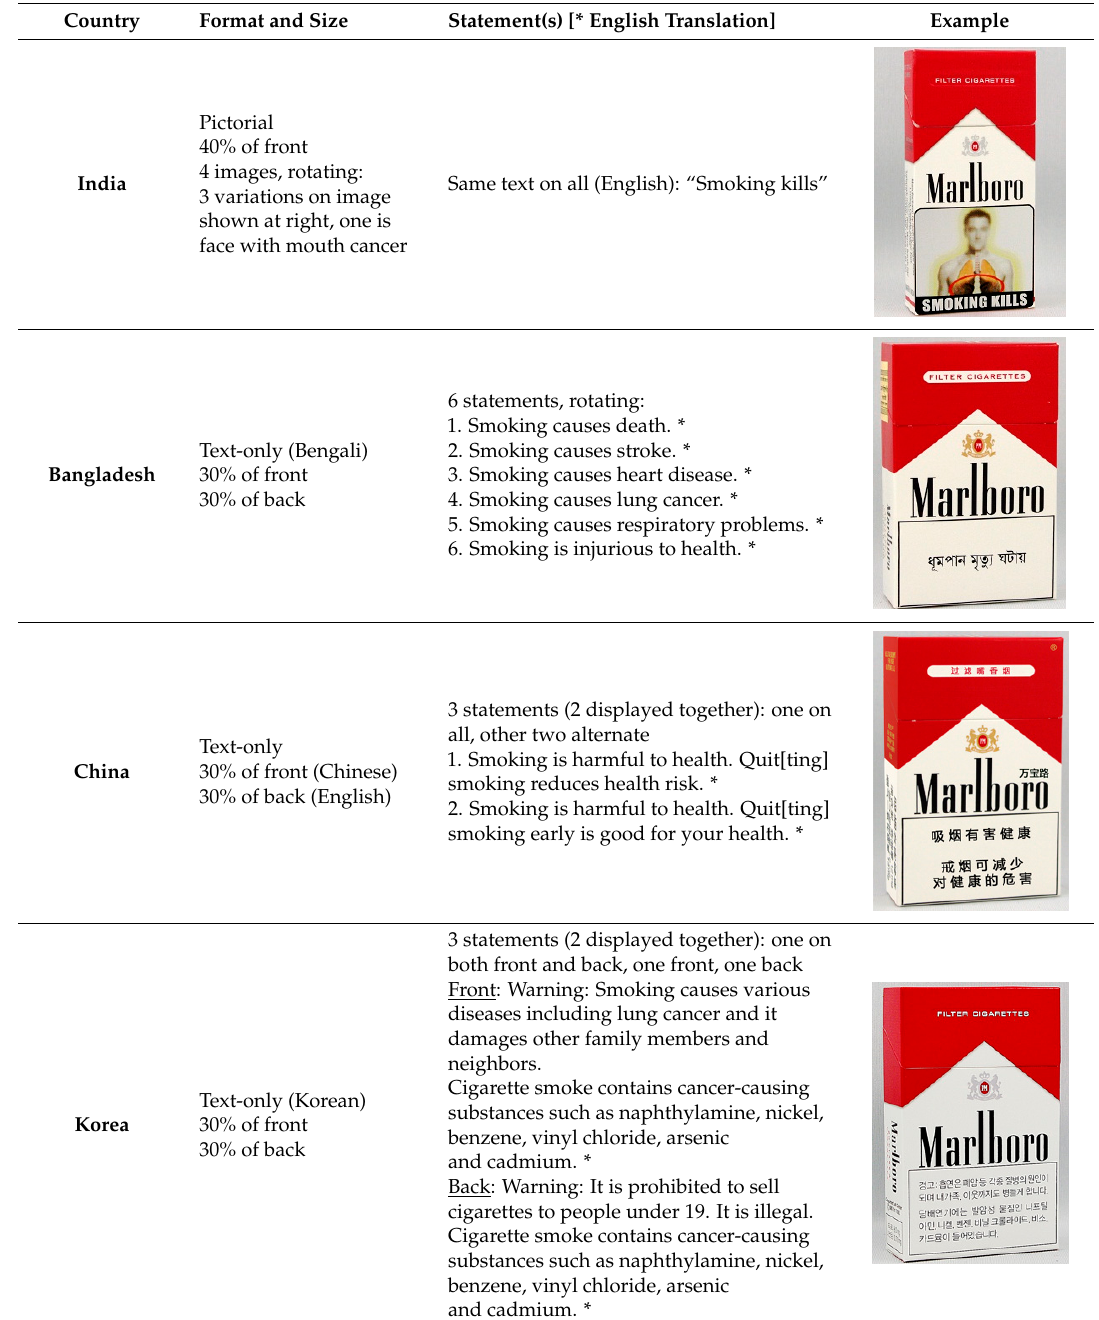
Table 1. Health warning label characteristics in each of the countries at the time of study (2011–2012).